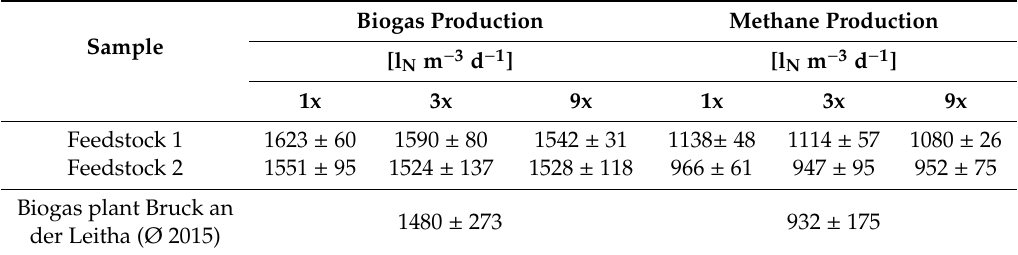
Table 2. Average daily biogas and methane production [l N m − 3 d − 1 ] from the semi-continuous experiment Figure 1. 3x and 9x feeding strategies. Feedstock 1: 1x: n = 32; 3x, 9x: n = 48; Feedstock